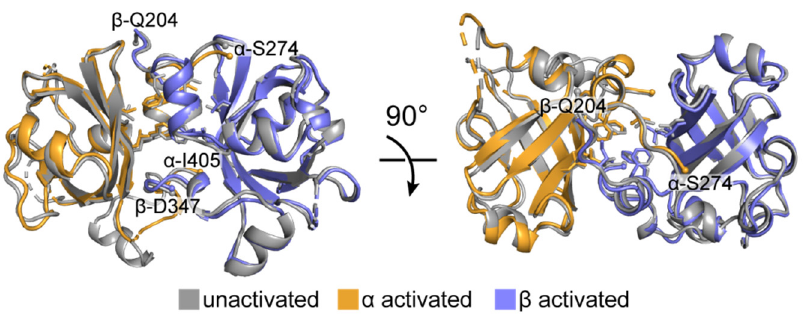
Figure 7. The two sGC PAS domains interact via a conserved dimerization motif and change very little upon activation. Superposition of the unactivated (grey, PDB ID 6JT0 [65]) and activated (colored as in Figure 4, PDB ID 6JT2 [65]) sGC PAS domains. The hydrophobic residues ( α -I277, α -F282, α -F286, α -L380, α -L382; β -I208, β -F213, β -F217, β -L320, β -L322) that interact at the dimer interface are shown as sticks. Structures were aligned by secondary structure matching over both chains (r.m.s.d. = 0.96 Å for 234 residues aligned). The N- and C-terminal residues of each domain are labeled and shown as small spheres (C-terminal residue labels have been omitted from the bottom panel).